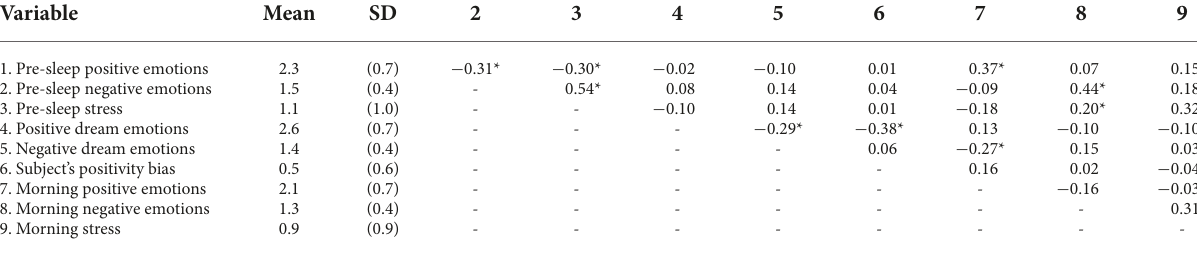
TABLE 1 Means, standard deviations, and correlations among the variables in those who had positive dream nights. Variable Mean